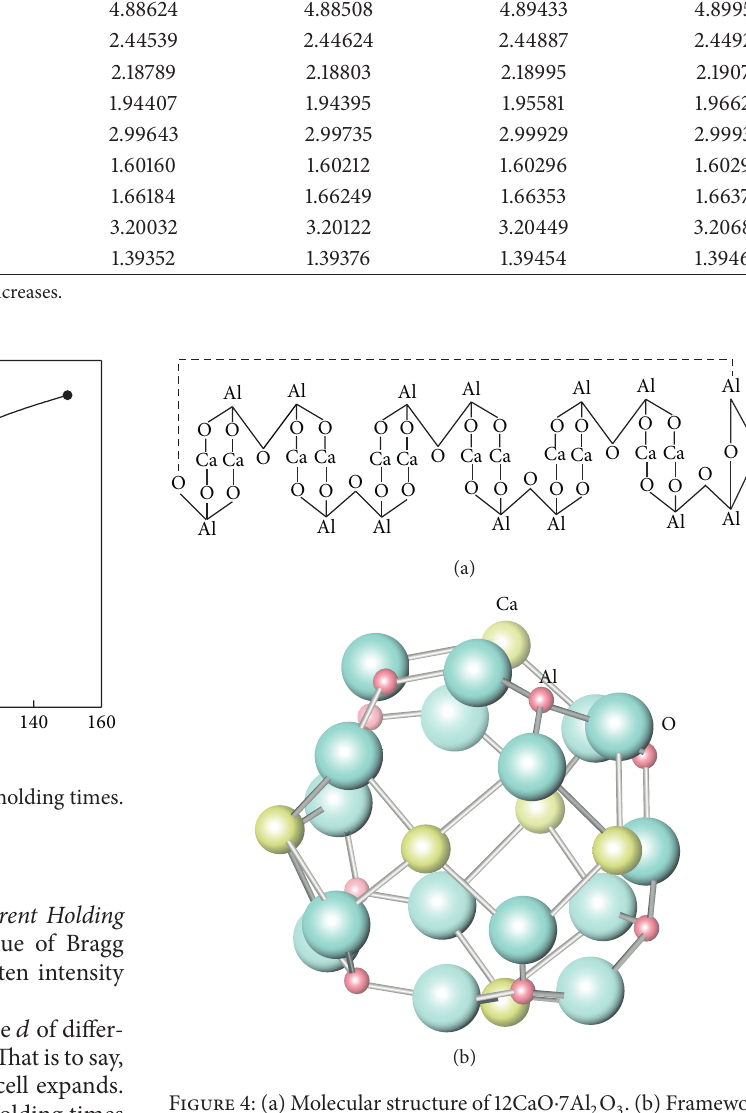
Figure 4: (a) Molecular structure of 12CaO ⋅ 7Al 2 O 3 . (b) Framework of single